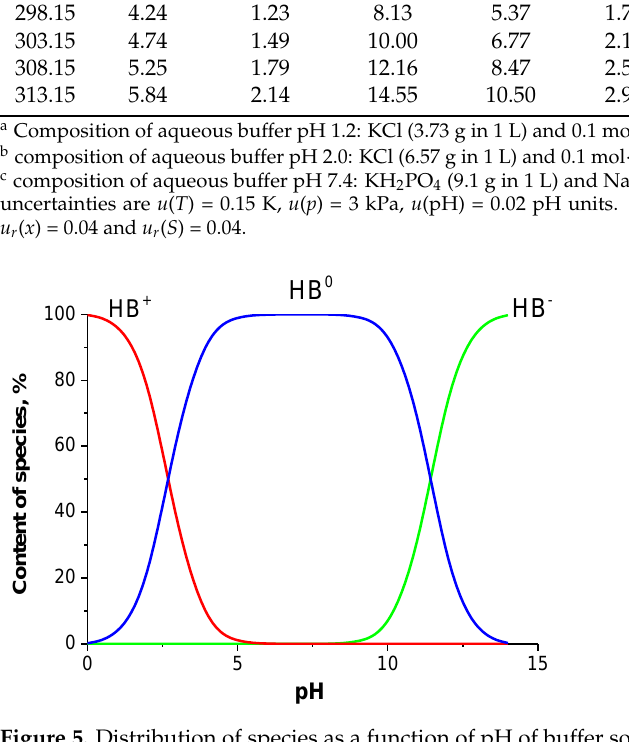
Figure 5. Distribution of species as a function of pH of buffer solution for IVZ.